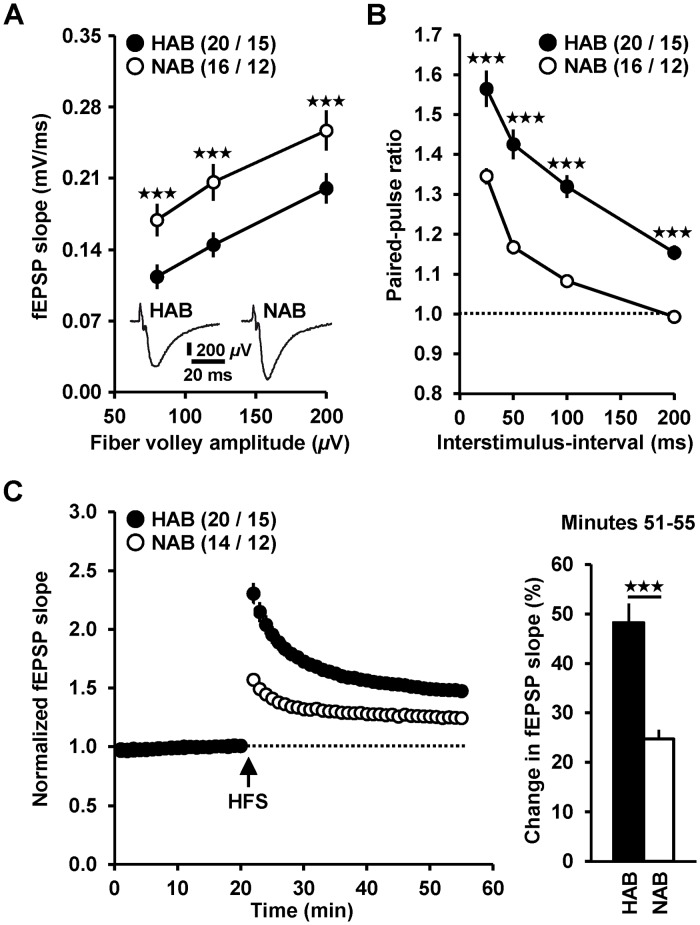
HAB (black circles) and NAB (open circles) mice exhibit differences in electrophysiological properties in the vHPC.(A) HAB mice show weaker basal neurotransmission since the input-output curve is shifted towards smaller fEPSP amplitudes compared to NAB animals. (B) PPF is stronger in HAB compared to NAB animals at interstimulus-intervals of 25, 50, 100, and 200 ms, suggesting a lower probability of neurotransmitter release. (C) LTP at ventral CA3-CA1 synapses is more pronounced in slices from HAB mice. For clarity, stimulus artifacts in recording traces (A) were truncated in part. n numbers are indicated in brackets as follows (slices / animals).